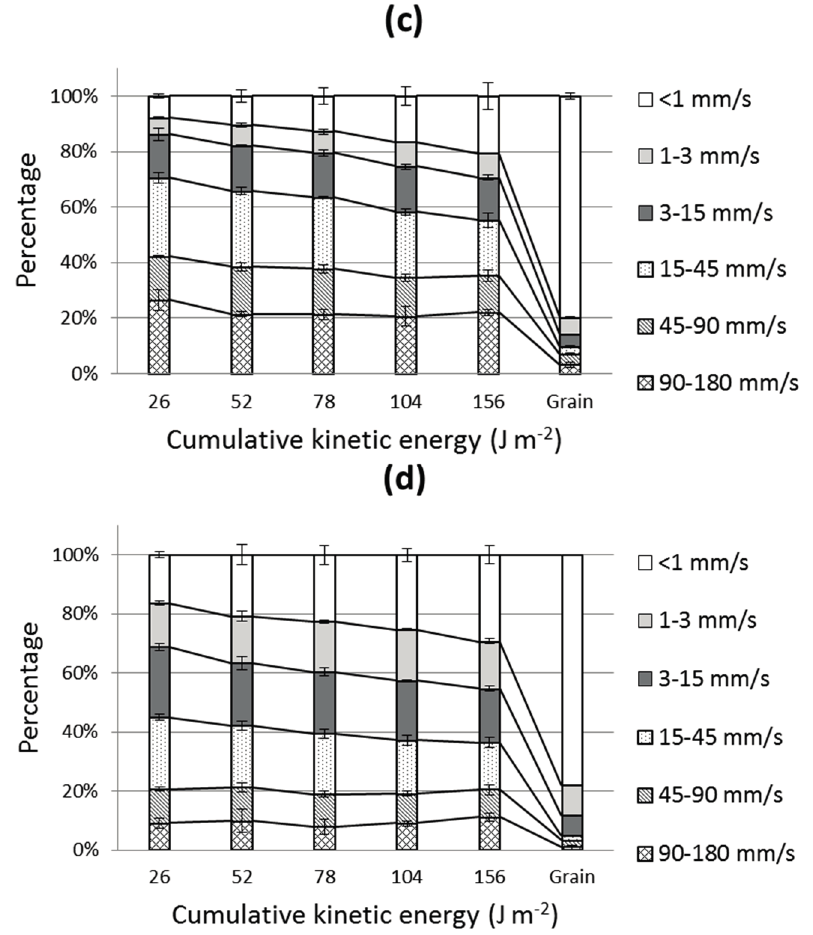
Figure 3. The settling velocity distributions after different cumulative kinetic energy of ( a ) the Möhlin soil; ( b ) the Weinan soil; ( c ) the Exeter soil and ( d ) the Eifel soil. “Grain” represents the settling distribution based on soil texture after dispersion. “100 (FLM)” and “200 (FLM)” represent the EQS distribution of eroded sediment from a flume (FLM) (Hu and Kuhn [30]) after 100 and 200 J·m − 2 ·of cumulative kinetic energy impact. Bars represent standard